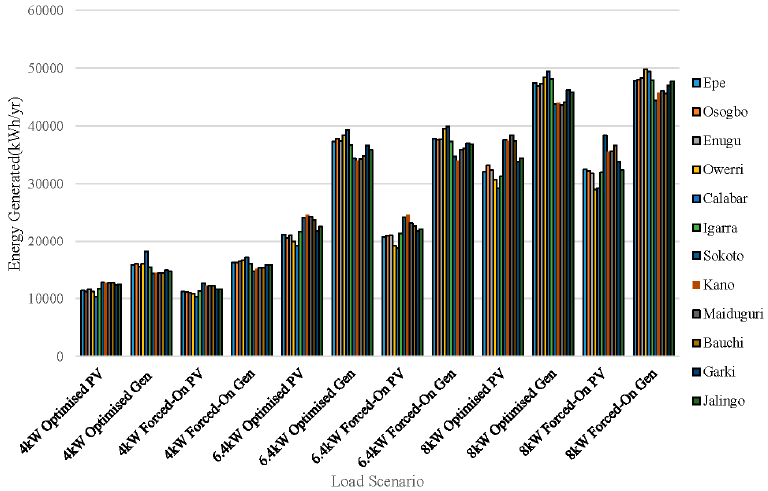
Figure 6. Energy generated comparison of optimised and forced-on (kWh/year).